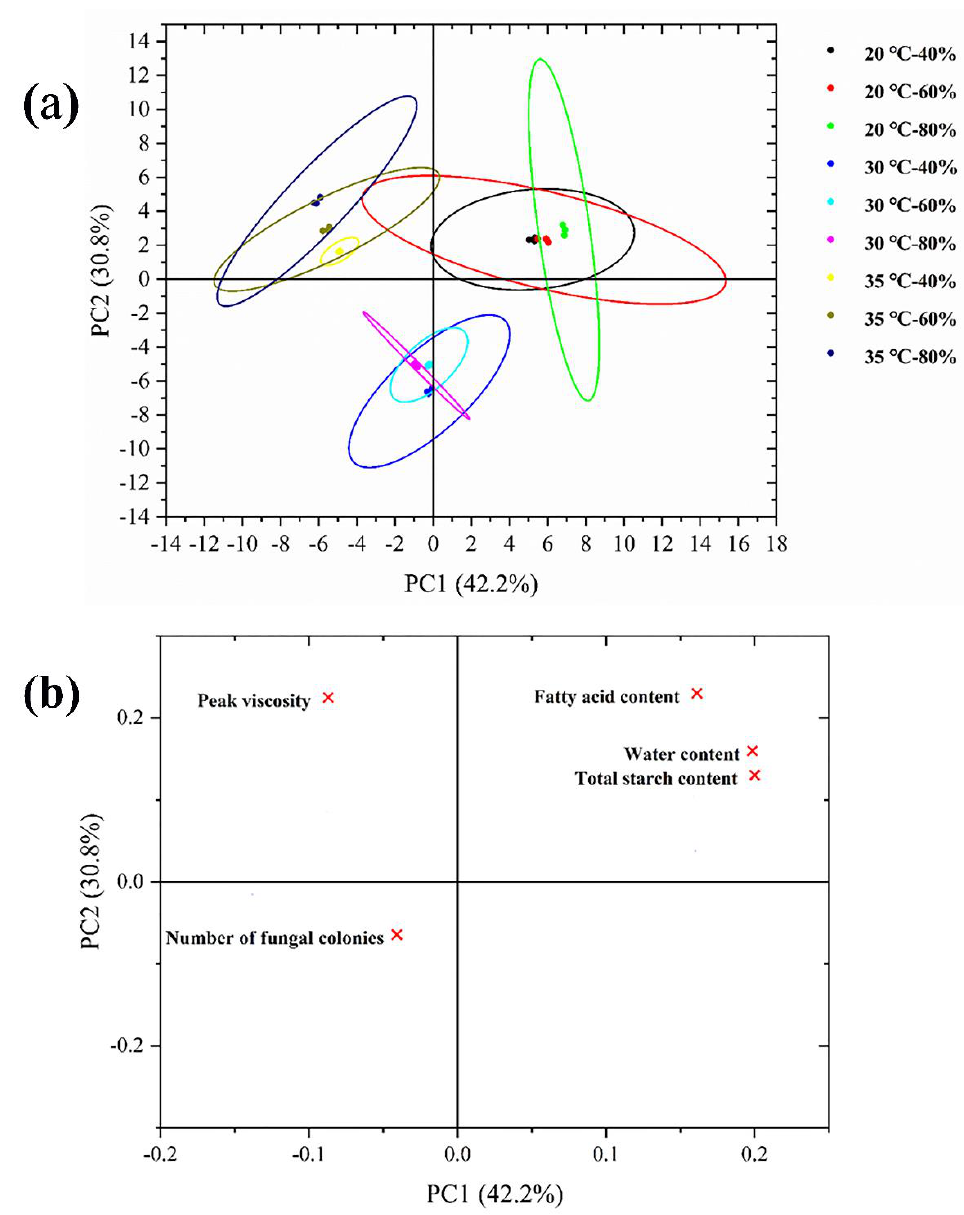
Figure 8. ( a ) PCA score plot and ( b ) PCA loading plot based on the critical point of mildew in stored rice . Note: × represents an important index in the process of rice